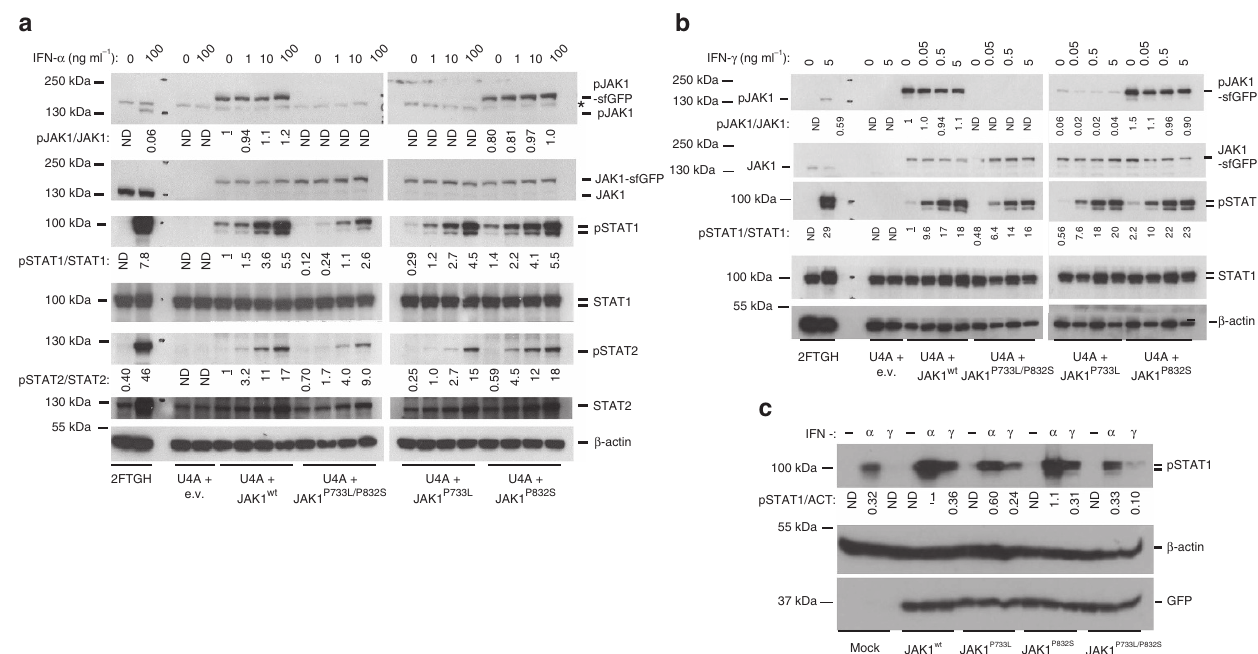
Figure 7 | P733L mutation impairs JAK1 function. ( a , b ) JAK1-deficient fibrosarcoma cells, U4A, were transfected for 24h with vectors expressing sfGFP-fused JAK1 WT , JAK1 P733L , JAK1 P832S or JAK1 P733L/P832S . Then, cells were exposed to the indicated concentrations of IFN- a ( a ) or IFN- g ( b ) for 15min. Cells transfected with empty vector (e.v.) and parental, JAK1-competent, fibrosarcoma cells 2fTGH, served as negative and positive controls, respectively. *shows non-specific protein species detected by the antibody. Representative of four independent experiments. Fold change of band densitometry is indicated (numbers below bands and bar graphs in Supplementary Fig. 9).( c ) Patient fibroblasts were transduced with vectors expressing JAK1 WT , JAK1 P733L , JAK1 P832S or JAK1 P733L/P832S and eGFP. Cells were stimulated with either IFN- a (100ngml (cid:2) 1 ) or IFN- g (1ngml (cid:2) 1 ) or medium ( (cid:2) ). One experiment. Fold change of band densitometry is indicated (numbers below bands).